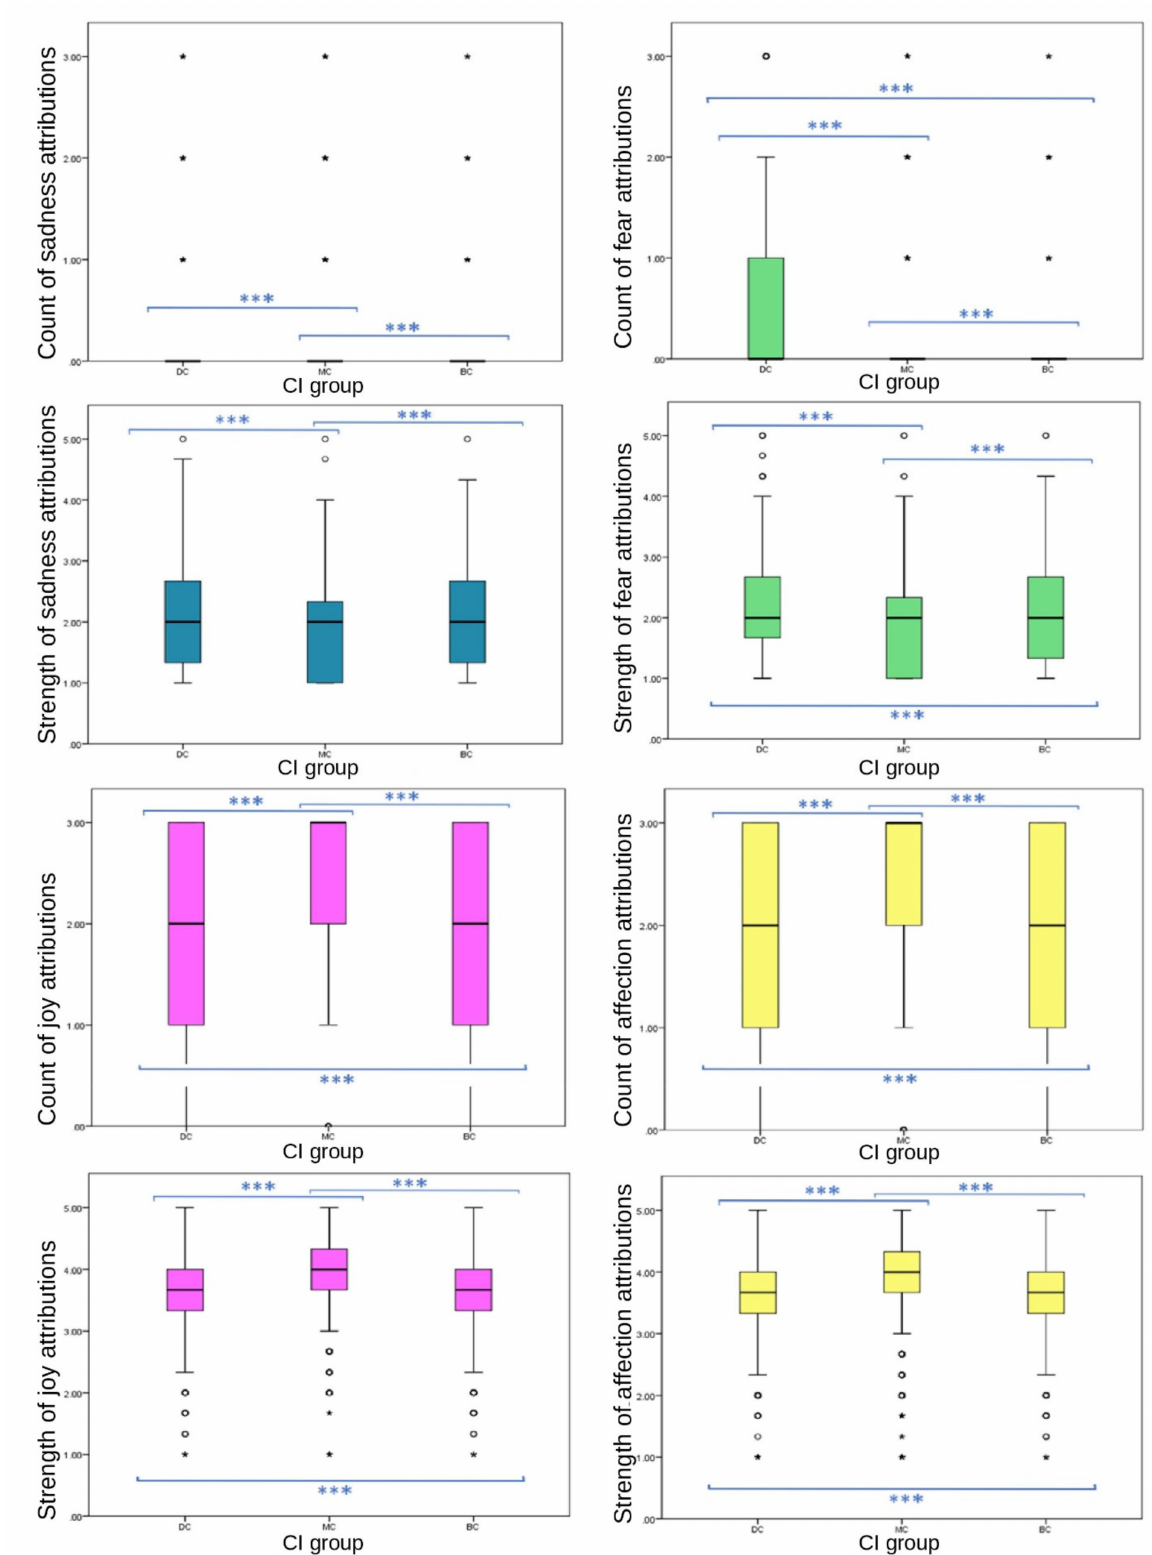
Figure 2. Box plots describing mean scores of individual primary emotion attribution strengths and frequencies between CI groups of dog images. (*** demotes statistically significant differences. ◦ denotes